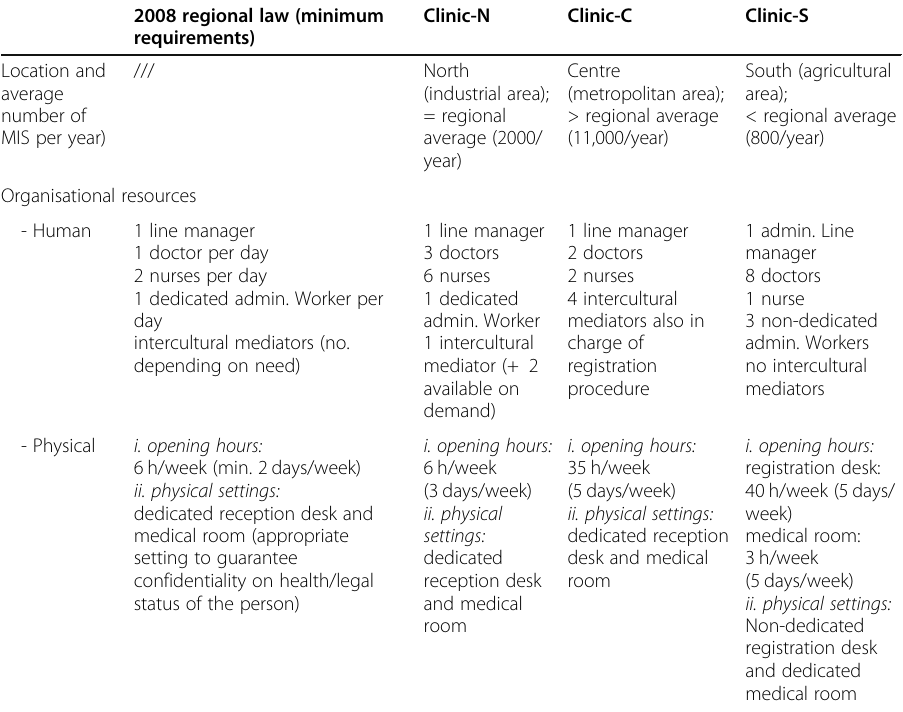
Clinic-N Clinic-C Clinic-S